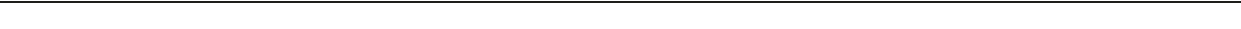
Fig. 5 Nascent A-ROD enhances DKK1 transcription elongation. a RT-qPCR assaying the steady-state chromatin-associated RNA levels of A-ROD, DKK1 and two unrelated transcripts, using several amplicons, at 16 h post-transfection of 50 nM ASOs targeting A-ROD intronic sequences (see also Supplementary Fig. 5a-b and Supplementary Fig. 7a). Error bars represent standard deviations from three independent experiments ( n = 3 biological replicates, * p < 0.05 and ** p < 0.01, two-tailed Student ’ s t -test). b RT-qPCR assaying the steady-state nucleoplasmic RNA levels using several amplicons at three time-points post-transfection of pooled intronic ASO sequences transfected at 100 nM fi nal concentration; either ASO 3 and 4 targeting the fi rst